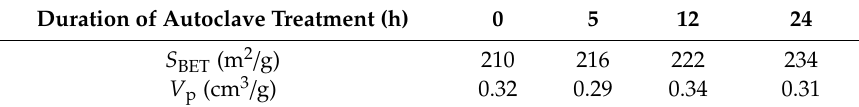
Table 2. Textural properties of binary M2/SiO 2 90:10 mixed oxides.